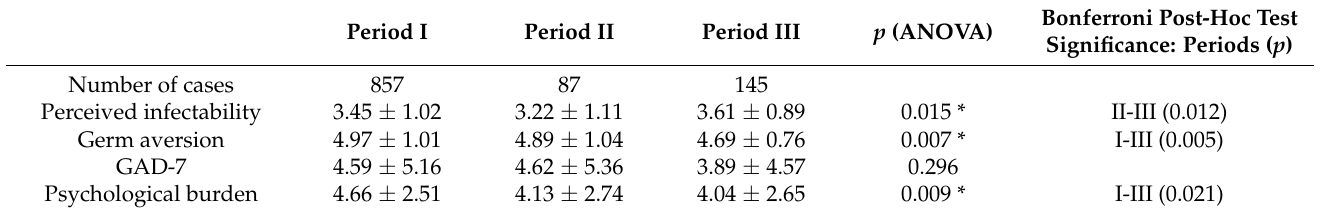
Table 3. Comparison of the psychological scores in different survey periods (ANOVA and Bonferroni post-hoc test). Period I Period